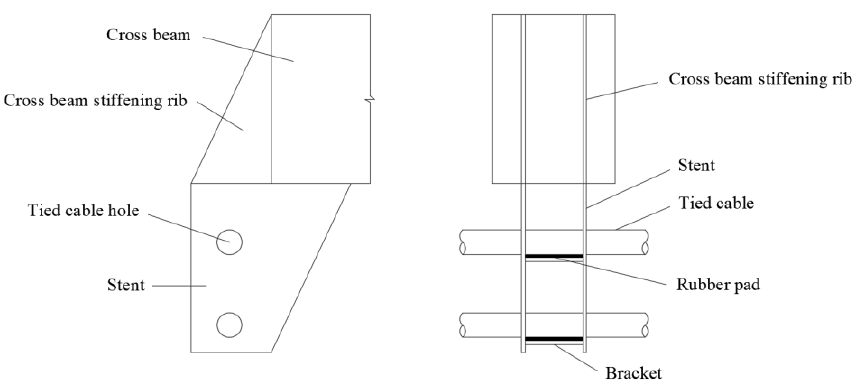
Figure 13. Design of the support frame.